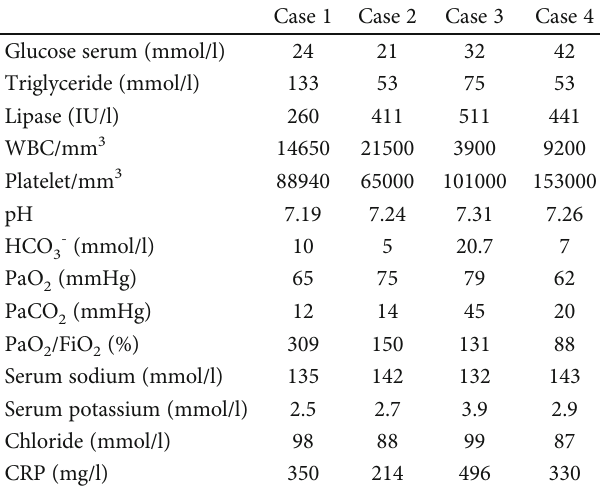
Table 2: Laboratory results on ICU